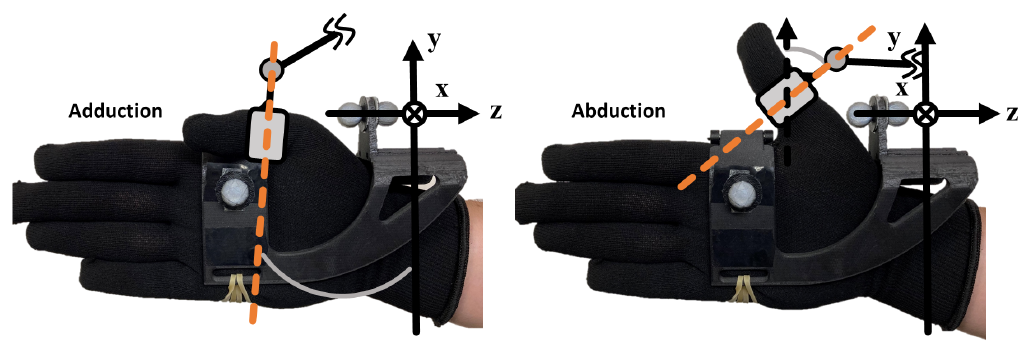
Figure 19. Range of the required orientation angle when thumb equipped the output link (Adduction-Abduction